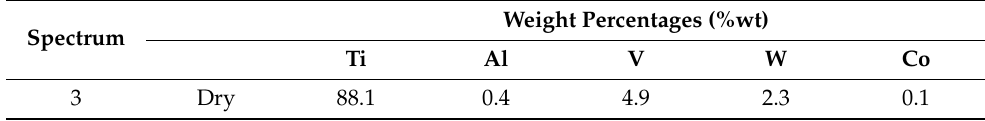
Table 4. EDS weight percentages at different spectra after longitudinal